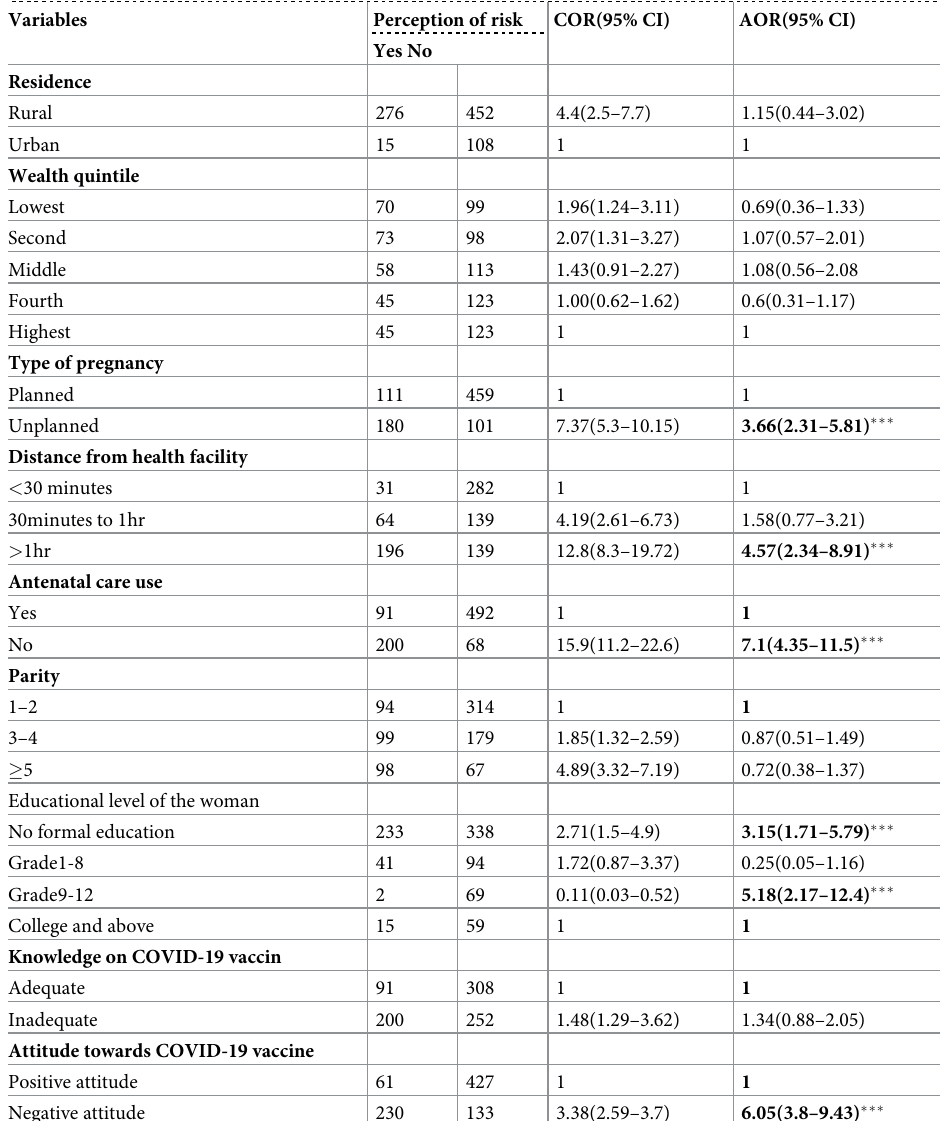
Table 3. Bivariable and multivariable logistic regression analysis of factors associated with the perception of risk COVID-19 vaccination during pregnancy, in Motta town and Hulet Eji Enese district, northwest Ethiopia,